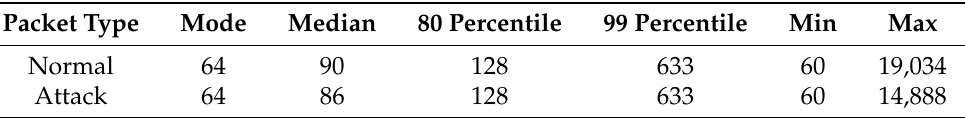
Table 1. Statistics on packet length